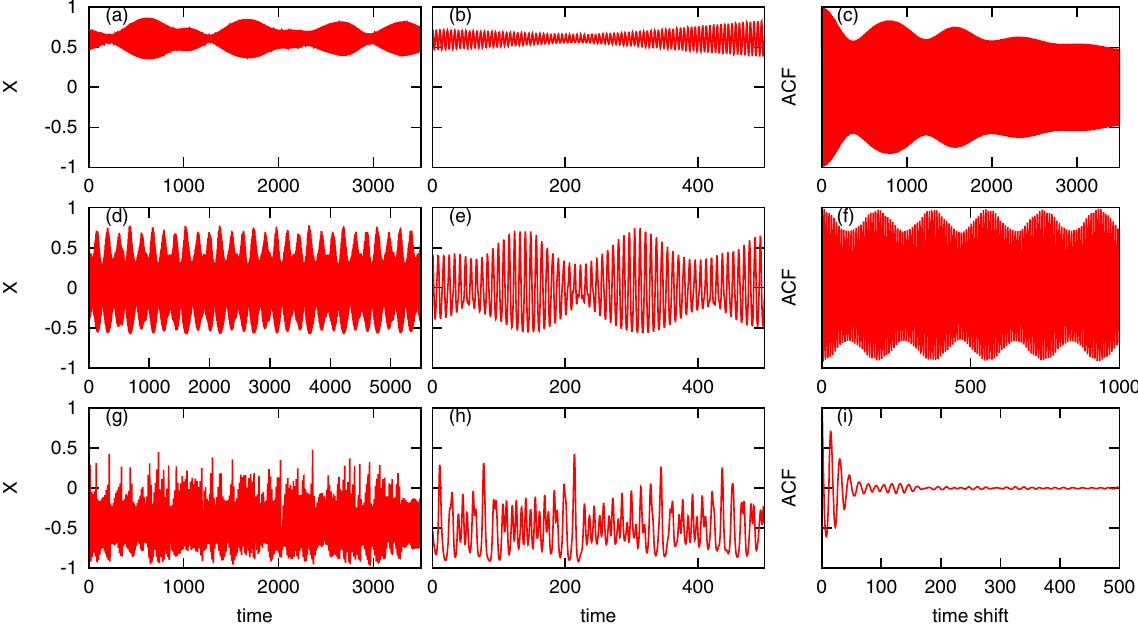
Figure 3. Different nontrivial dynamical regimes of the mean field X ( t ). Panels (a,b,c): I = 0.006; panels (d,e,f): I = 0.008; panels (g,h,i): I = 0.012. All data are for an array of N = 1000 oscillators with parameters ε = 0.3 and τ = 6. Panels (b,e,h) show details of evolution on a shorter timescale. Panels (c,f,i) show the corresponding normalized autocorrelation functions, see section Methods for the details of their